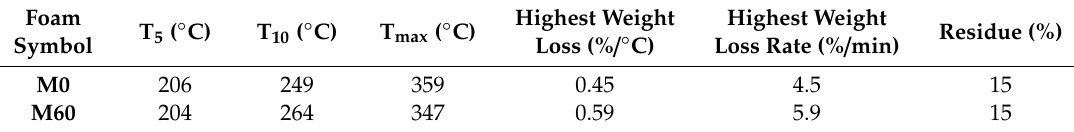
Table 7. Results of thermogravimetric analysis (TGA) of reference foam M0 and M60 foam—containing 60 wt.% of rapeseed cake.